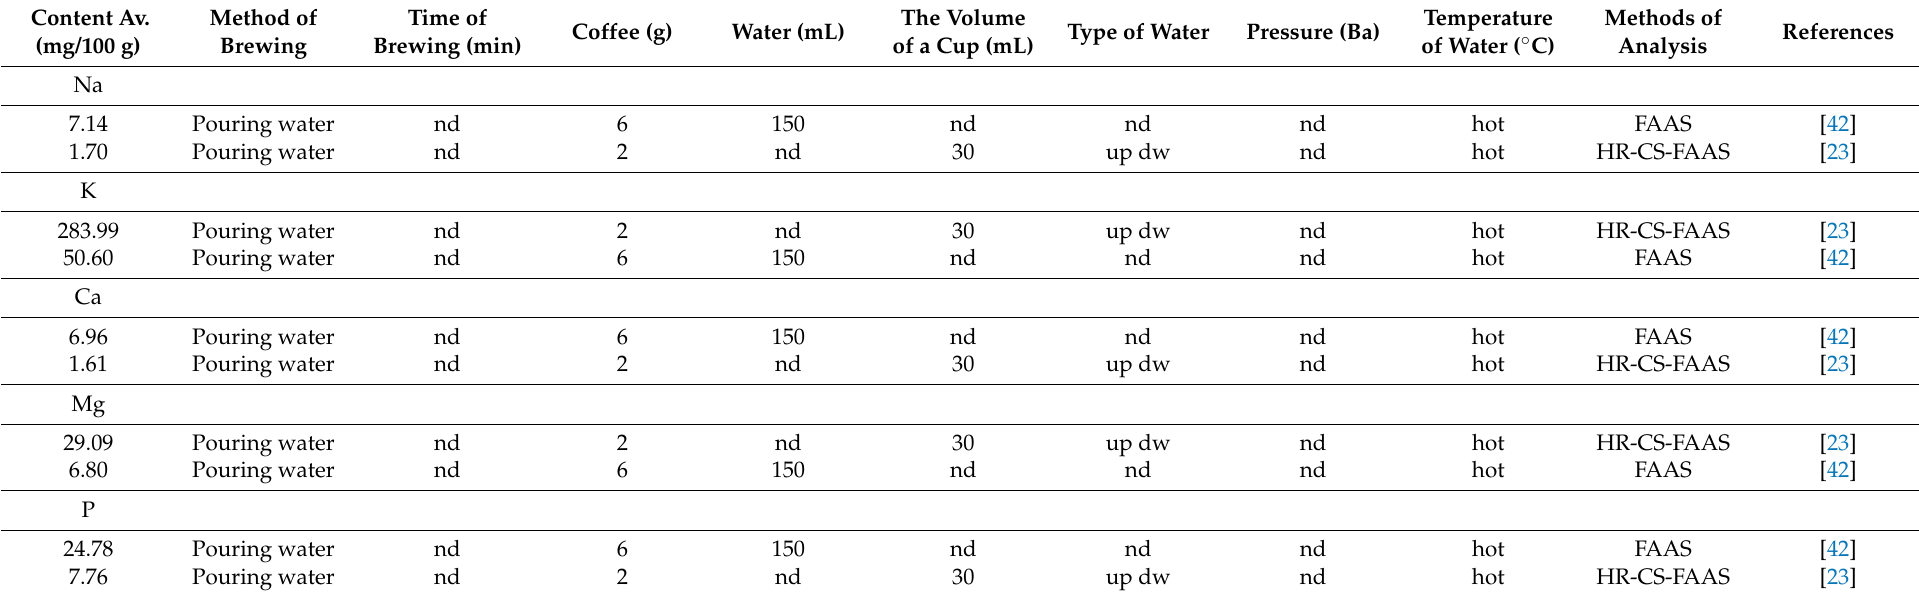
Table 2. The content of macroelements per 100 g of instant coffee (no declaration: species, degree of roasting, and origin). Content